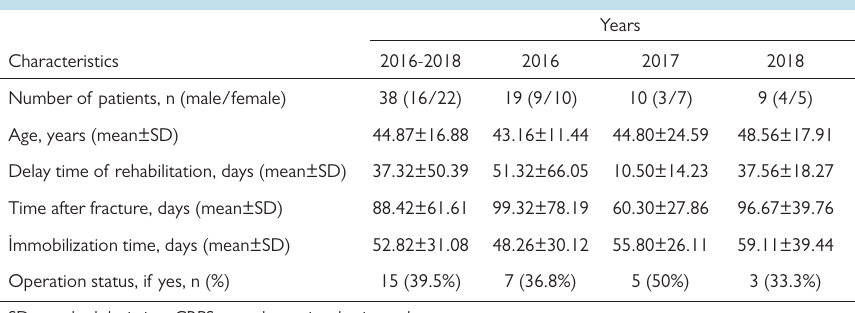
Table 1. Characteristics of CRPS-1 patients